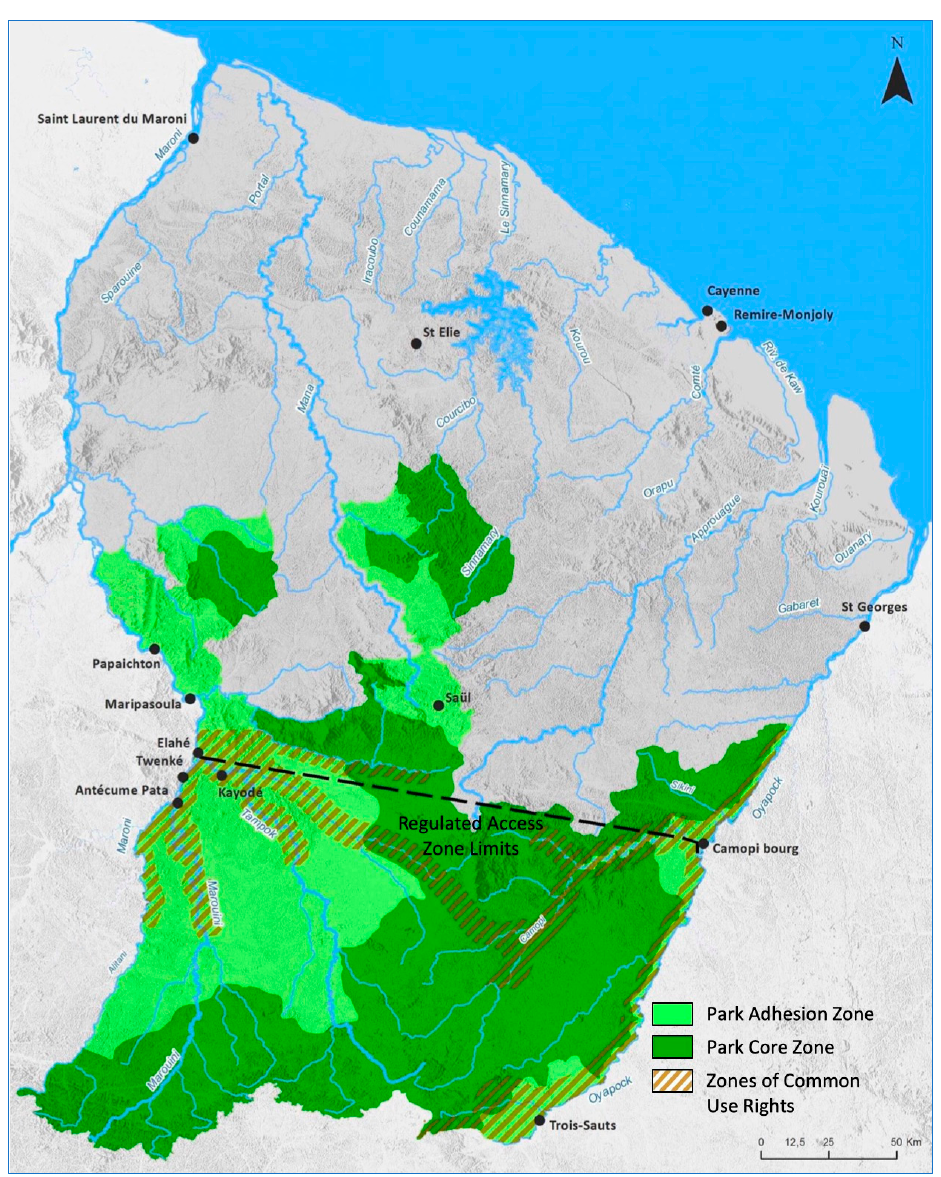
Figure 7. Territorial management (Source: Guiana Amazonian Park—modified by authors).